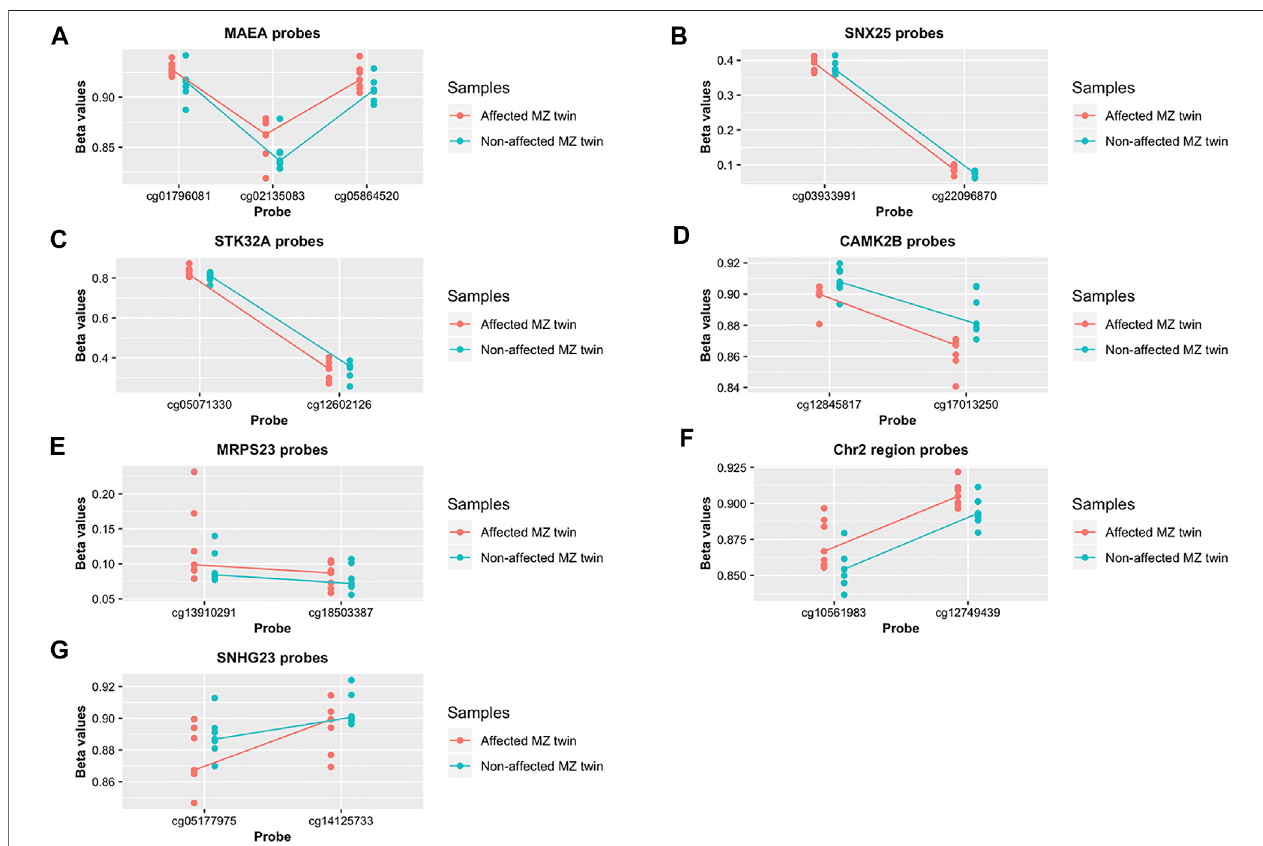
FIGURE 4 | Differential methylation pattern identi fi ed in whole blood psoriatic disease MZ twins (A – G) . Methylation level of the DMPs localized in the 7 regions characterized by concordant β -value variation. Data are presented as a scatterplot, including the individual data points (for the 7 monozygotic twin pairs) that represent the beta values of the signi fi cant DMPs. The lines connect the median methylation value of each CpG site, in affected and healthy twins separately (represented in pink and blue, respectively).